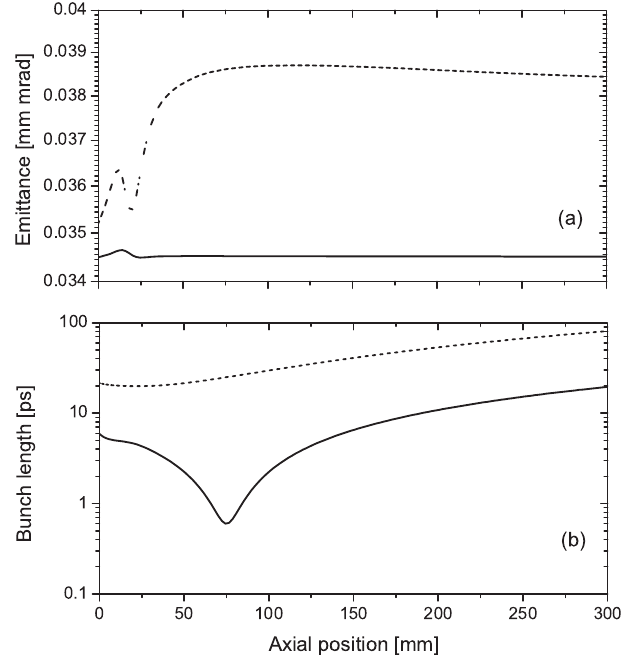
FIG. 12. GPT simulations using a SUPERFISH field map with a slew rate of 0 : 7 kV = ns : (a) rms normalized emittance; (b) rms bunch length; both of them as a function of axial position z . The dashed line is for 100 fC and the solid line for 1